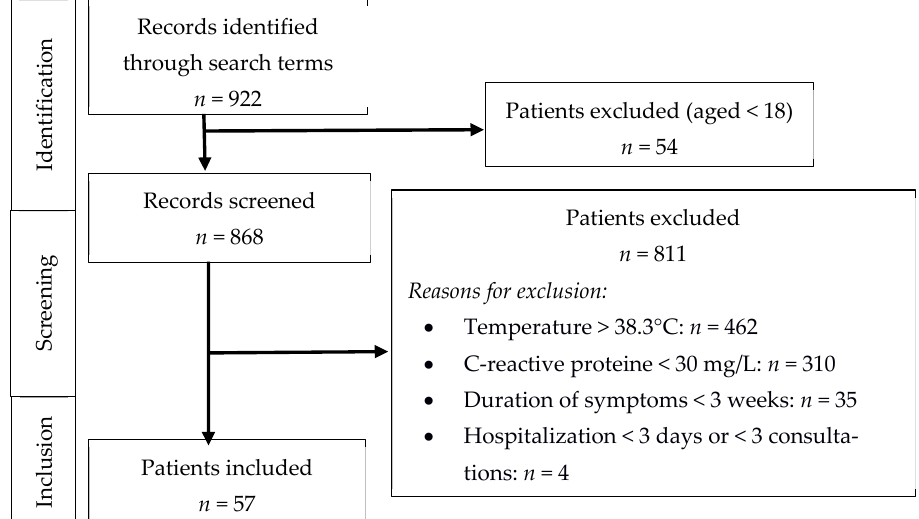
Figure 1. Flow chart.